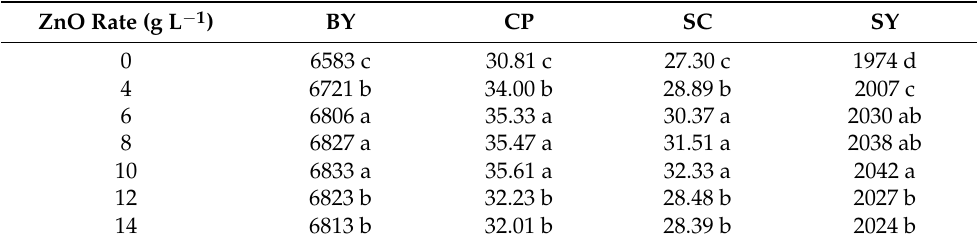
Table 5. Effect of foliar application of ZnO on biomass yield, number of capitula per plant, number of seeds per capitula, and seed yield of safflower (first